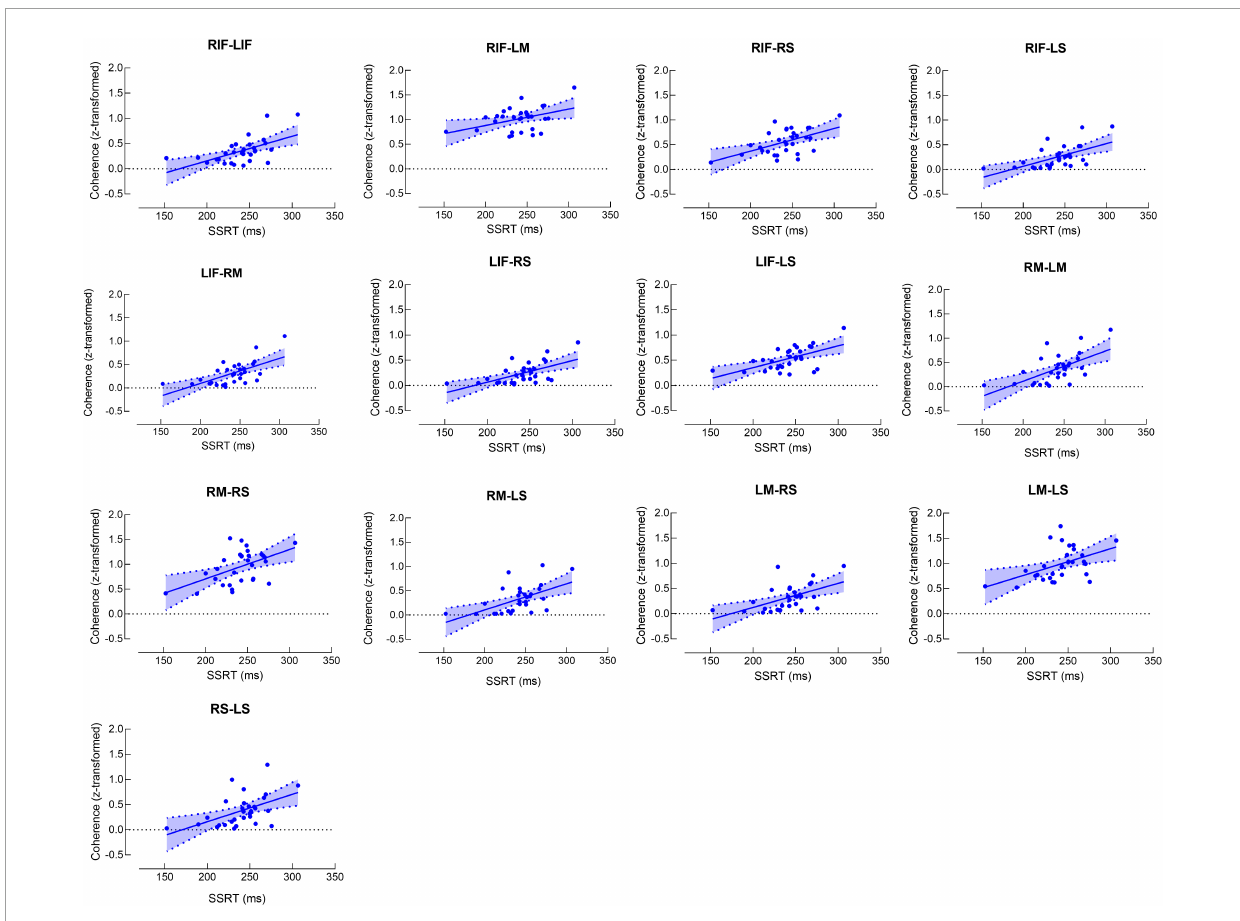
FIGURE3 Scatter plots for correlations between stop-signal reaction time (SSRT) and beta band coherence. Each scatter plot represents significant positive correlation between SSRT and beta band coherence in the pair of brain regions. RS and LS refer to right and left somatosensory cortex, respectively. RM and LM refer to right and left motor cortex, respectively. RIF and LIF refer to right and left inferior frontal cortex, respectively.